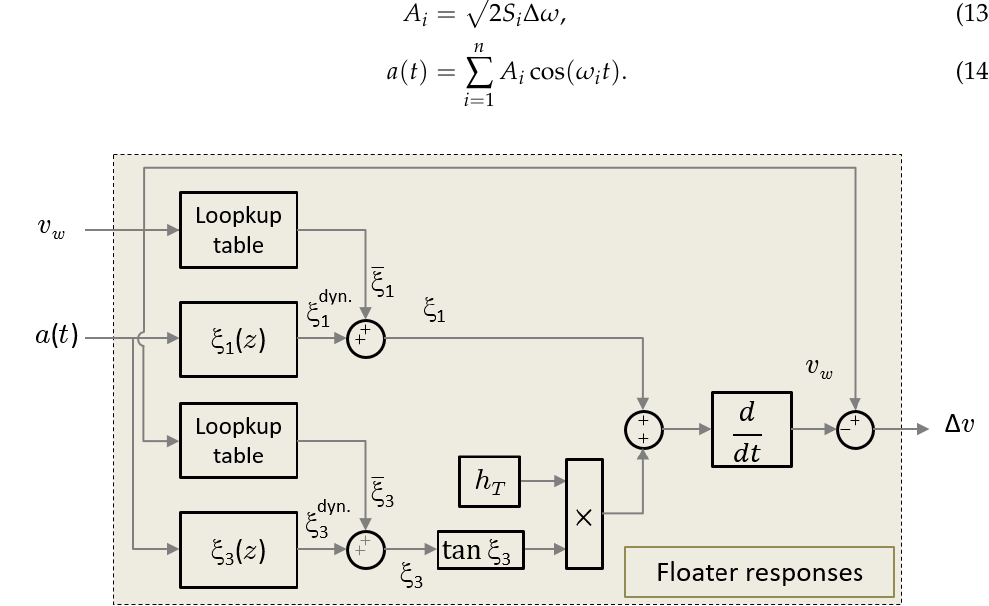
Figure 5. Overall configuration of simplified FOWT